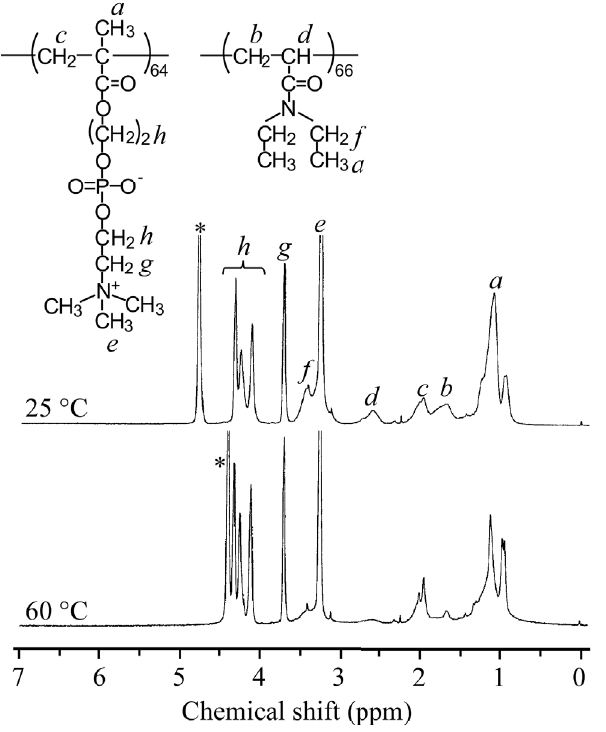
Figure 4. Comparison of 1 H NMR spectra for PMPC D O containing 0.1 M NaCl at C 2